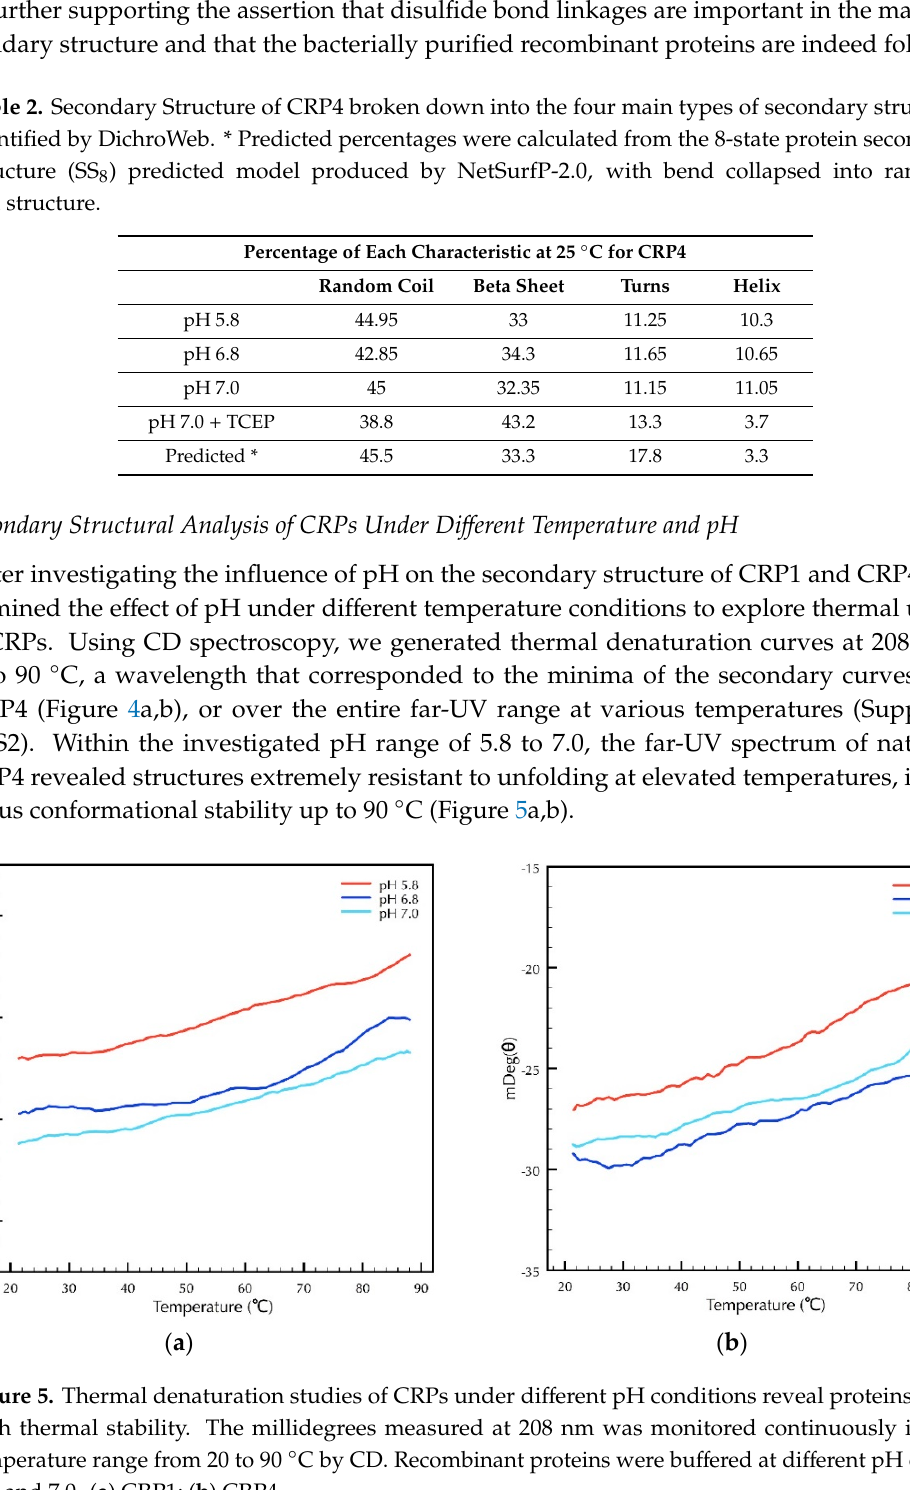
Table 2. Secondary Structure of CRP4 broken down into the four main types of secondary structure identified by DichroWeb. * Predicted percentages were calculated from the 8-state protein secondary structure (SS 8 ) predicted model produced by NetSurfP-2.0, with bend collapsed into random coil structure.